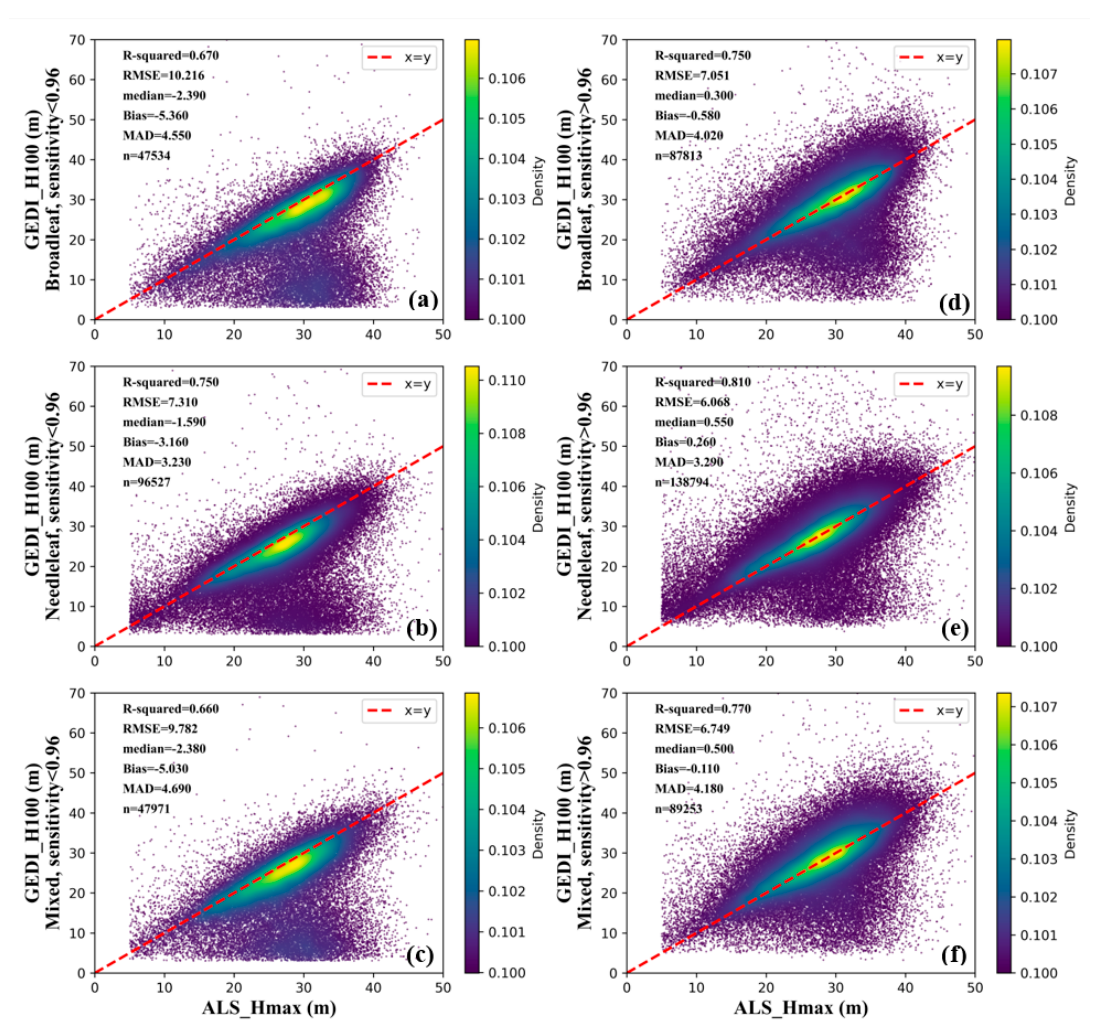
Figure 7. GEDI-H100 versus ALS-Hmax in the three forest types with sensitivity < 0.96 ( a , b , c ) and sensitivity > 0.96 ( d , e , f ).